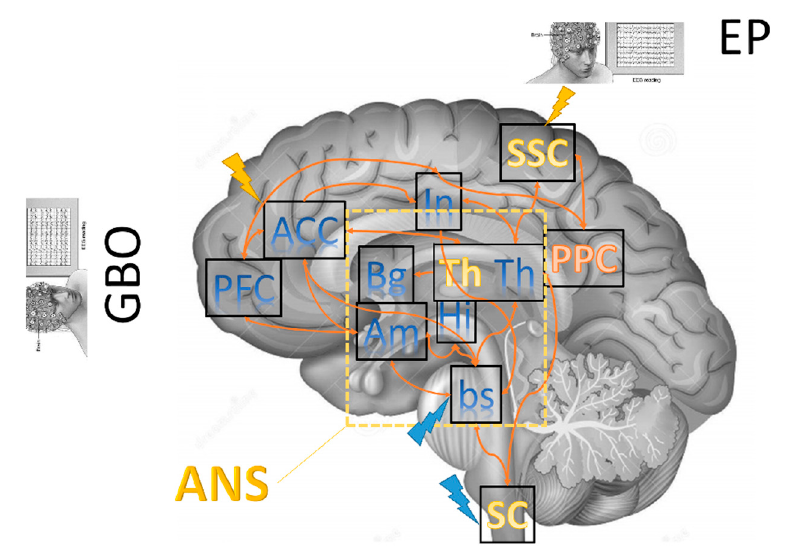
Figure 1. Illustration of the key brain areas related to pain processing and perception. They comprise densely interconnected sensory or discriminative (yellow tags), affective (blue tags), and associative areas (red tags). Brainstem and diencephalic areas are embedded within the autonomic nervous system (ANS) and can be evaluated using specific measures (including hearth rate variability). Sensory and/or nociceptive evoked potentials (EPs) and gamma-band oscillations (GBO) recorded using EEG can follow nociceptive stimulation (blue shock) combined or not with cortical stimulation using, e.g., transcranial magnetic stimulation (yellow shock). These represent the main neurophysiological paradigms available in the literature to gain objective measures of pain processing in PDOC patients. Legend: PFC, prefrontal cortex; ACC, anterior cingulate cortex; In, insula; Bg, basal ganglia; Am, amygdala; Hi, hippocampus; Th, thalamus; bs, brainstem; SC, spinal cord; SSC, somatosensory cortex; PPC, posterior parietal cortex.